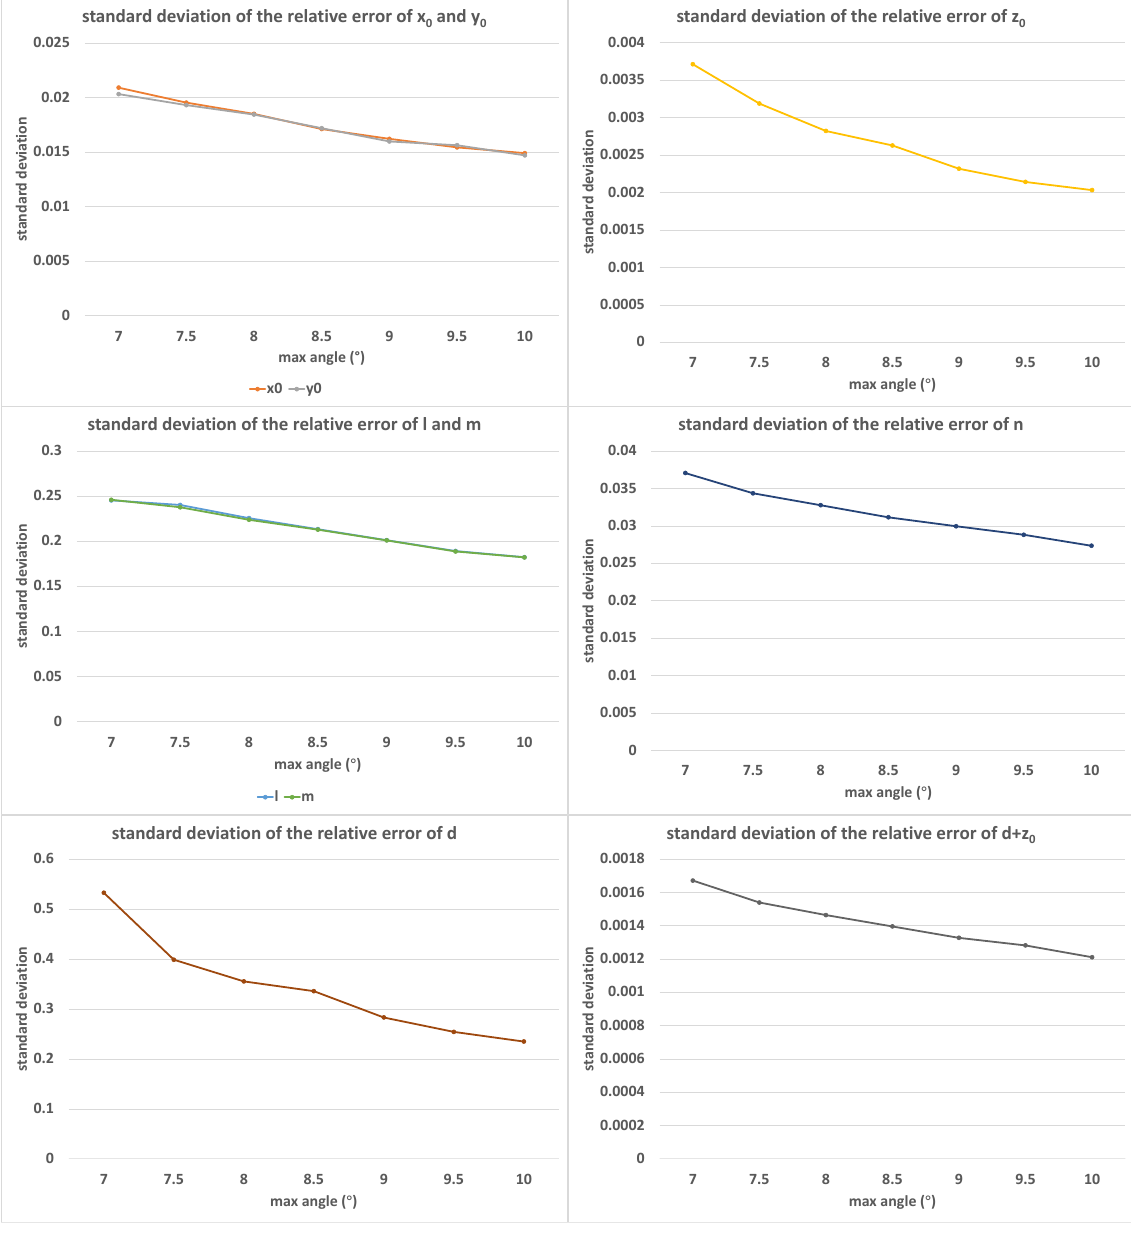
Figure 6. The standard deviations of relative errors of ( x 0 , y 0 , z 0 , l , m , n , d , d + z 0 ) with the increase in α ; the horizontal axis was measured in